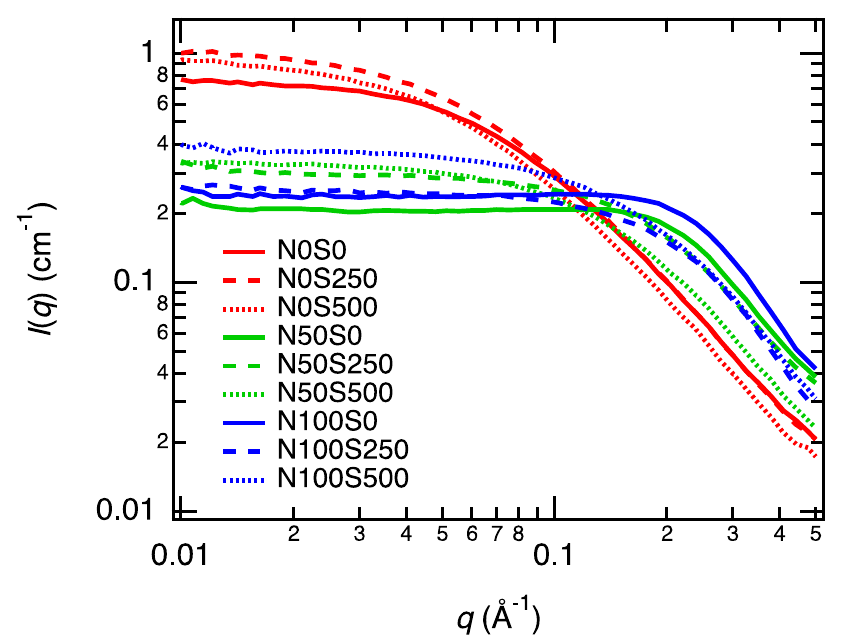
Figure 7. SAXS profiles of the equilibrated equivolume PAA gels, replotted from each panel in Fig ‐ ure 3. Figure